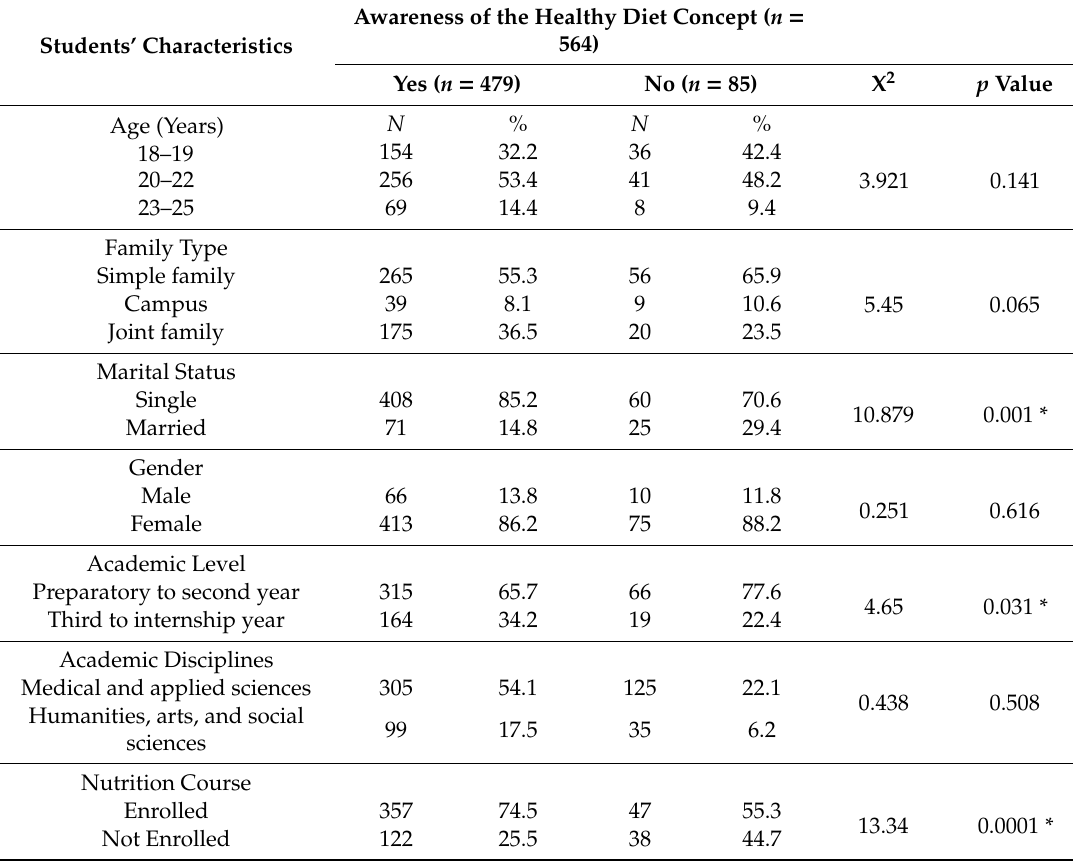
Table 5. Association between awareness of the concept of a healthy diet and student characteristics.